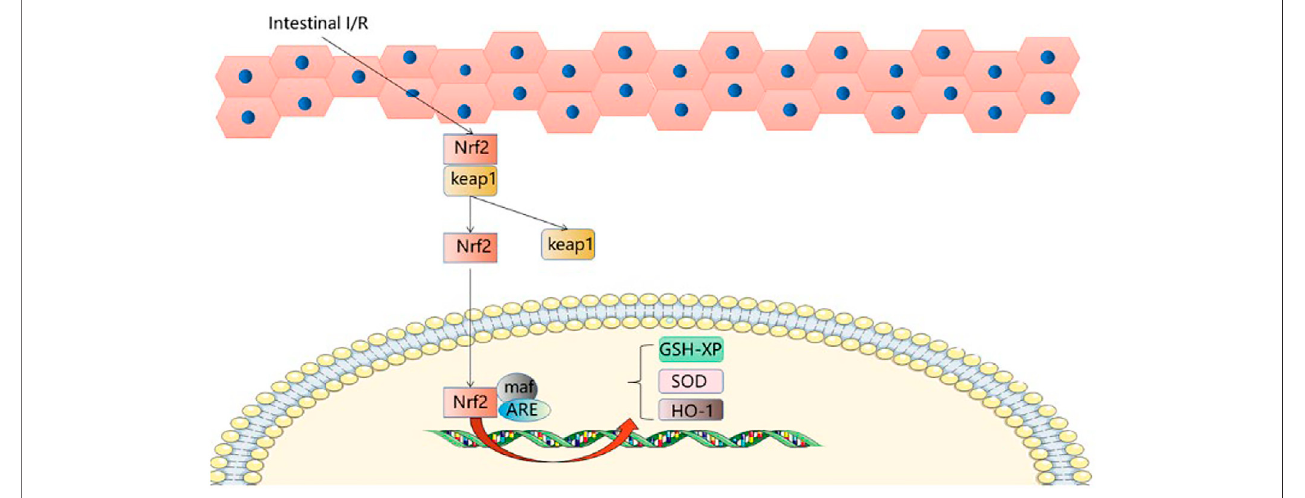
FIGURE 4 | Nrf2-ARE signaling